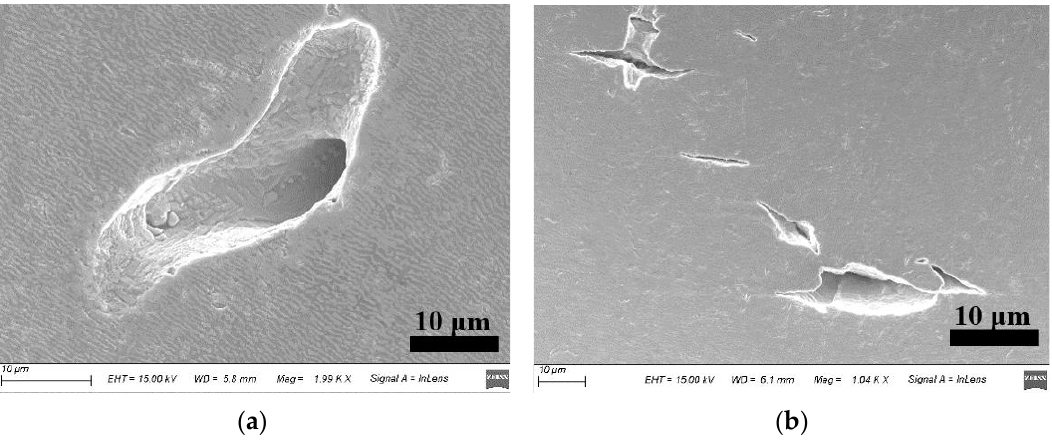
Figure 6. Defect morphology of creep fracture. ( a ) holes and ( b ) cracks.